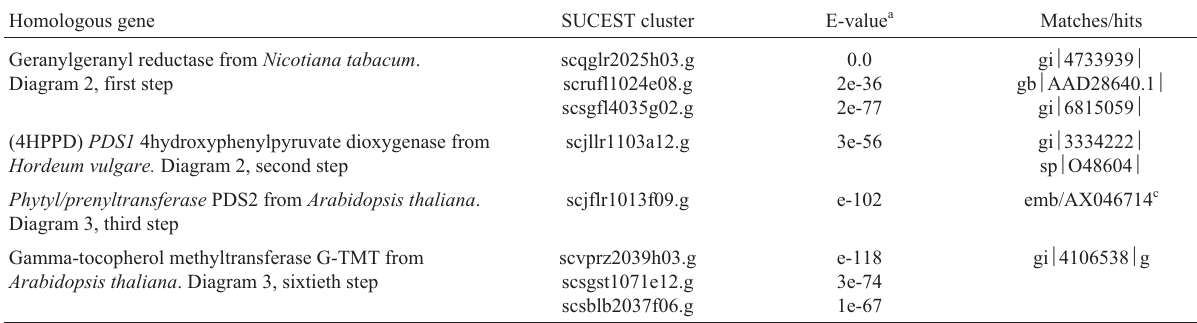
Table V - Homologues of the sugarcane alpha tocopherol biosynthetic pathway. Homologous gene SUCEST cluster